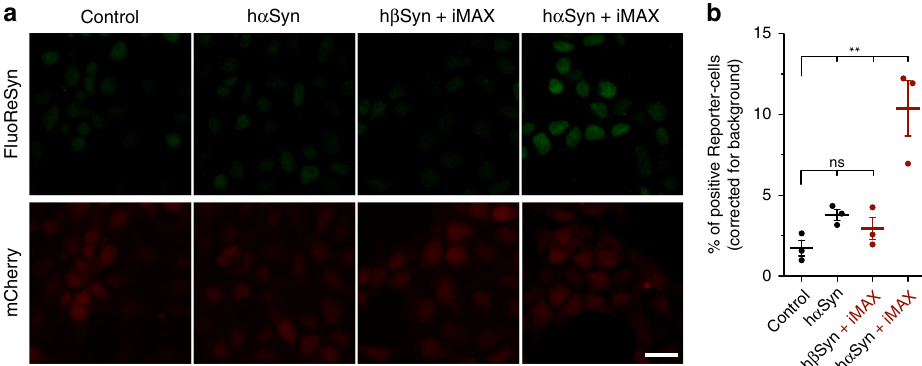
Fig. 5 Transmission of recombinant h α Syn into Reporter-cells. a Equally scaled representative epi fl uorescence images of Reporter-cells after incubation for 14 h with recombinant h α Syn monomers added to the culture medium. Monomers were either administered alone (h α Syn) or pre-mixed with the commercial cationic lipid mixture RNAiMAX (h α Syn + iMAX). h β Syn + iMAX was used as negative control. Scale bar represents 20 µ m. b Quanti fi cation of the percentage of EGFP-positive Reporter-cells. Error bars represent the SEM from three independent experiments ( n = 3). Per replication and condition >2300 cells were analyzed. One-way ANOVA with multiple comparison Tukey's post hoc test ** p < 0.01, ns: not signi fi cant. Source data is available as a Source data fi